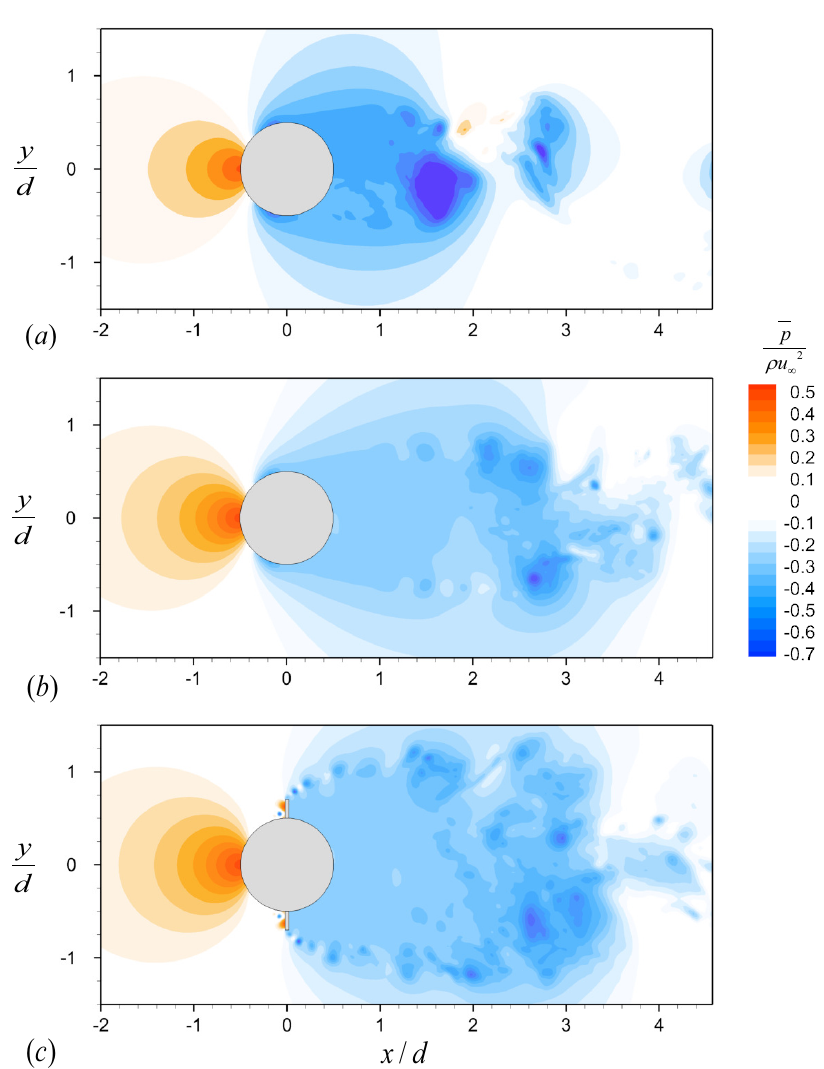
Figure 10. Instantaneous pressure contours over a circular cylinder with and without tabs on x – y planes. Details for ( a – c ) are the same as in the caption of Figure 9. In addition, the temporal instances for ( a – c ) are identical to those in Figure